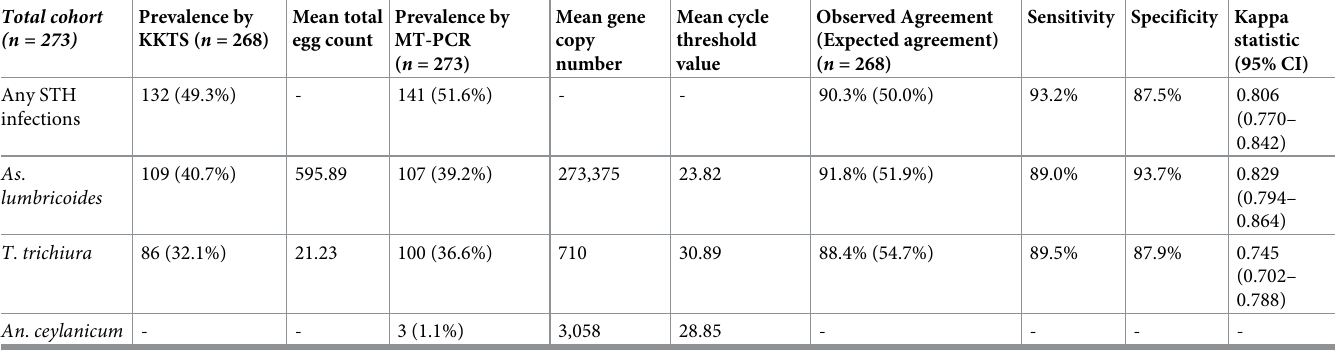
Table 1. STH infection prevalence and intensity among SAC children from Tha Song Yang district, Tak province, Thailand including all DESS preserved samples ( n = 273). Interrater reliability measure or kappa values are classified as follows: κ 0.0–0.2 non to slight, 0.2–0.4 fair,0.4–0.6 moderate, 0.6–0.8 substantial, 0.8–1.0 almost perfect [42]. Sensitivity is classified as the rate of true positive samples and specificity as the rate of true negative samples compared to a known gold standard (Kato Katz thick smear). Epidemiological and microscopy data for 5 individuals were missing. Prevalence by Mean total Prevalence by Total cohort KKTS ( n = 268) egg count (n = 273)